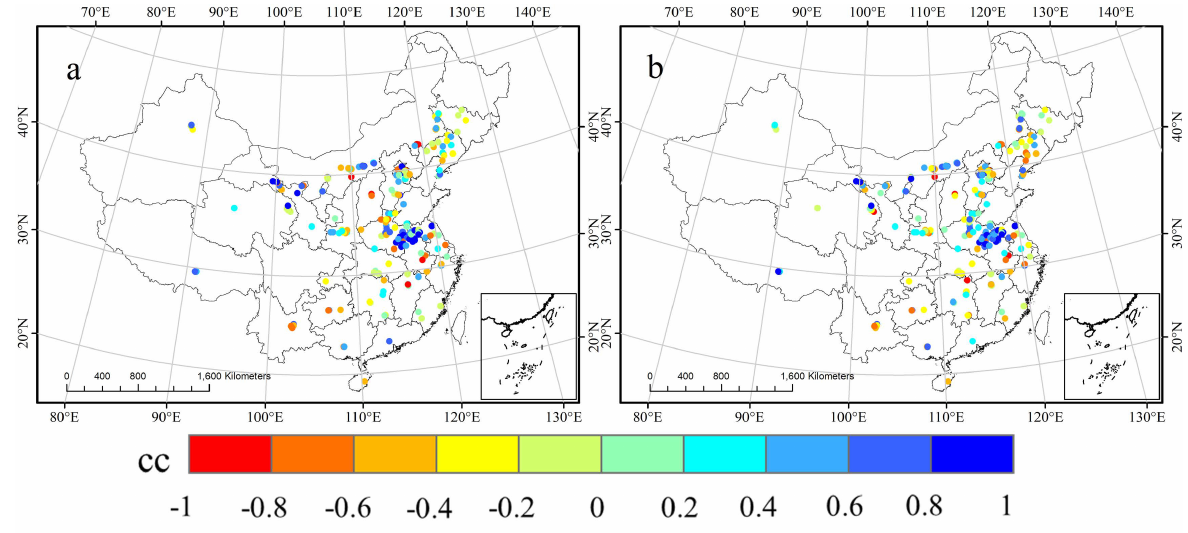
Figure 11. Correlation maps between the GWS and in situ measurements across China. ( a ) correlation map between the original GWS and in situ measurements ; ( b ) correlation map between the XGBoost-downscaled GWS and in situ measurements